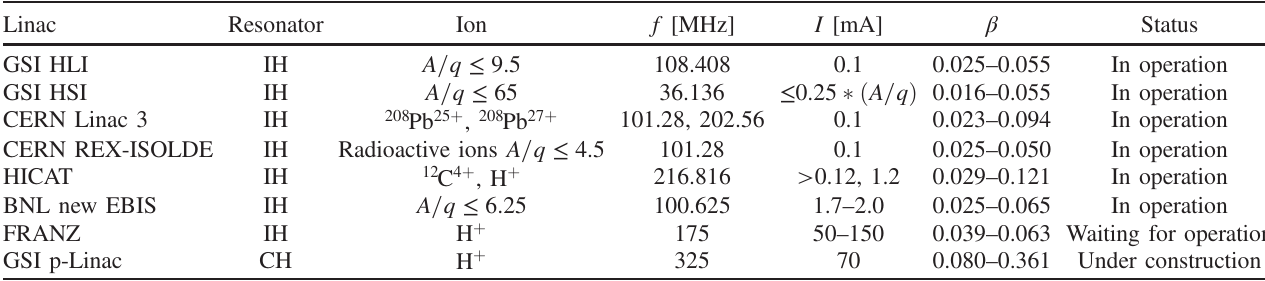
TABLE I. An overview of KONUS-based H-type DTLs.